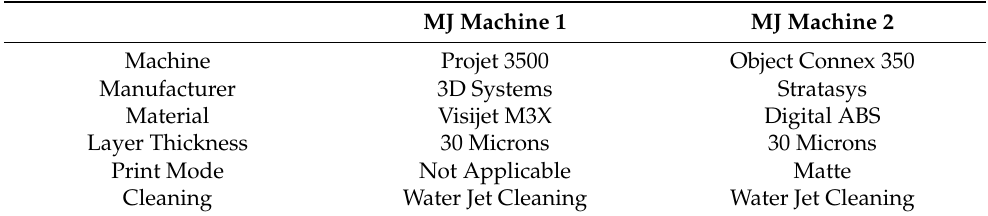
Table 2. Material specification and printing parameters used for printing 3DIM inserts gate (extracted and reproduced from Bagalkot et al. (2017) with permission [29]).